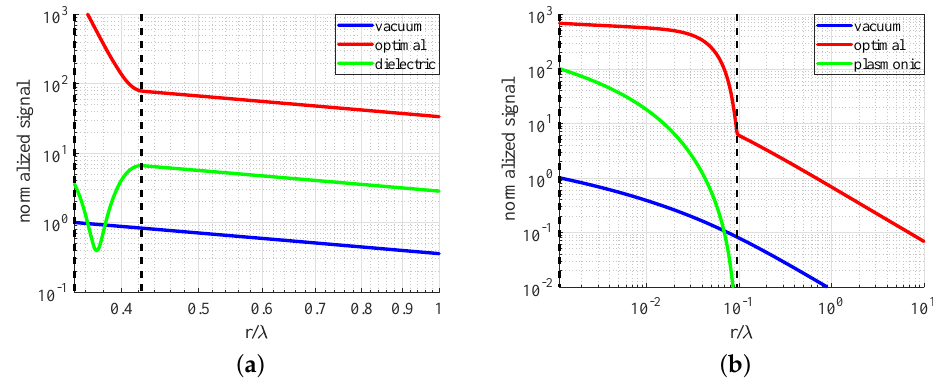
Figure 6. Linear plots of the normalized signal (field squared in arbitrary units) as a function of electrical radial distance r / λ for: ( a ) the optimal dimensions of the TM Ag-based design (of Figure 4) when the shell is empty (vacuum), silver (optimal), and a material with ε of the opposite real part than that of silver; ( b ) the optimal dimensions of the TE GaP-based design (of Figure 5) when the shell is empty (vacuum), GaP (optimal), and material with ε of the opposite real part than that of gallium phosphide. Vertical dashed lines denote the boundaries of the radiation-enhancing shell.